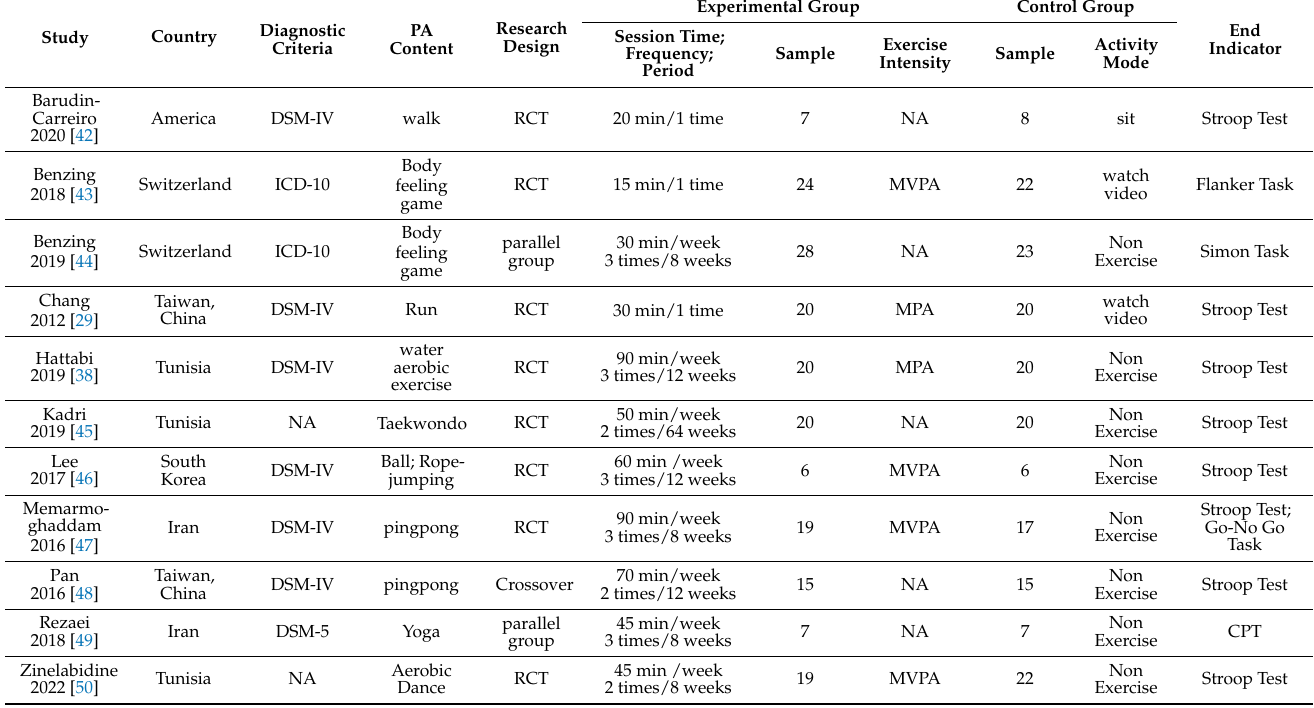
Table 1. Basic characteristics of the literature included in the study.